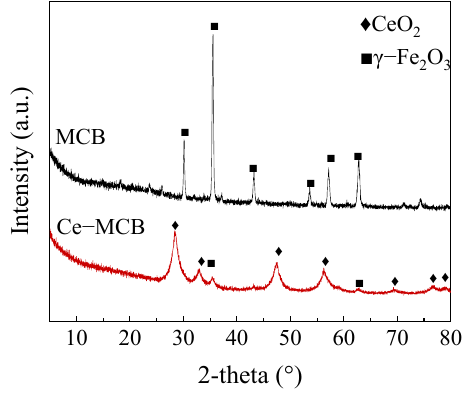
Figure 8. The XRD patterns of MCB and Ce-MCB.